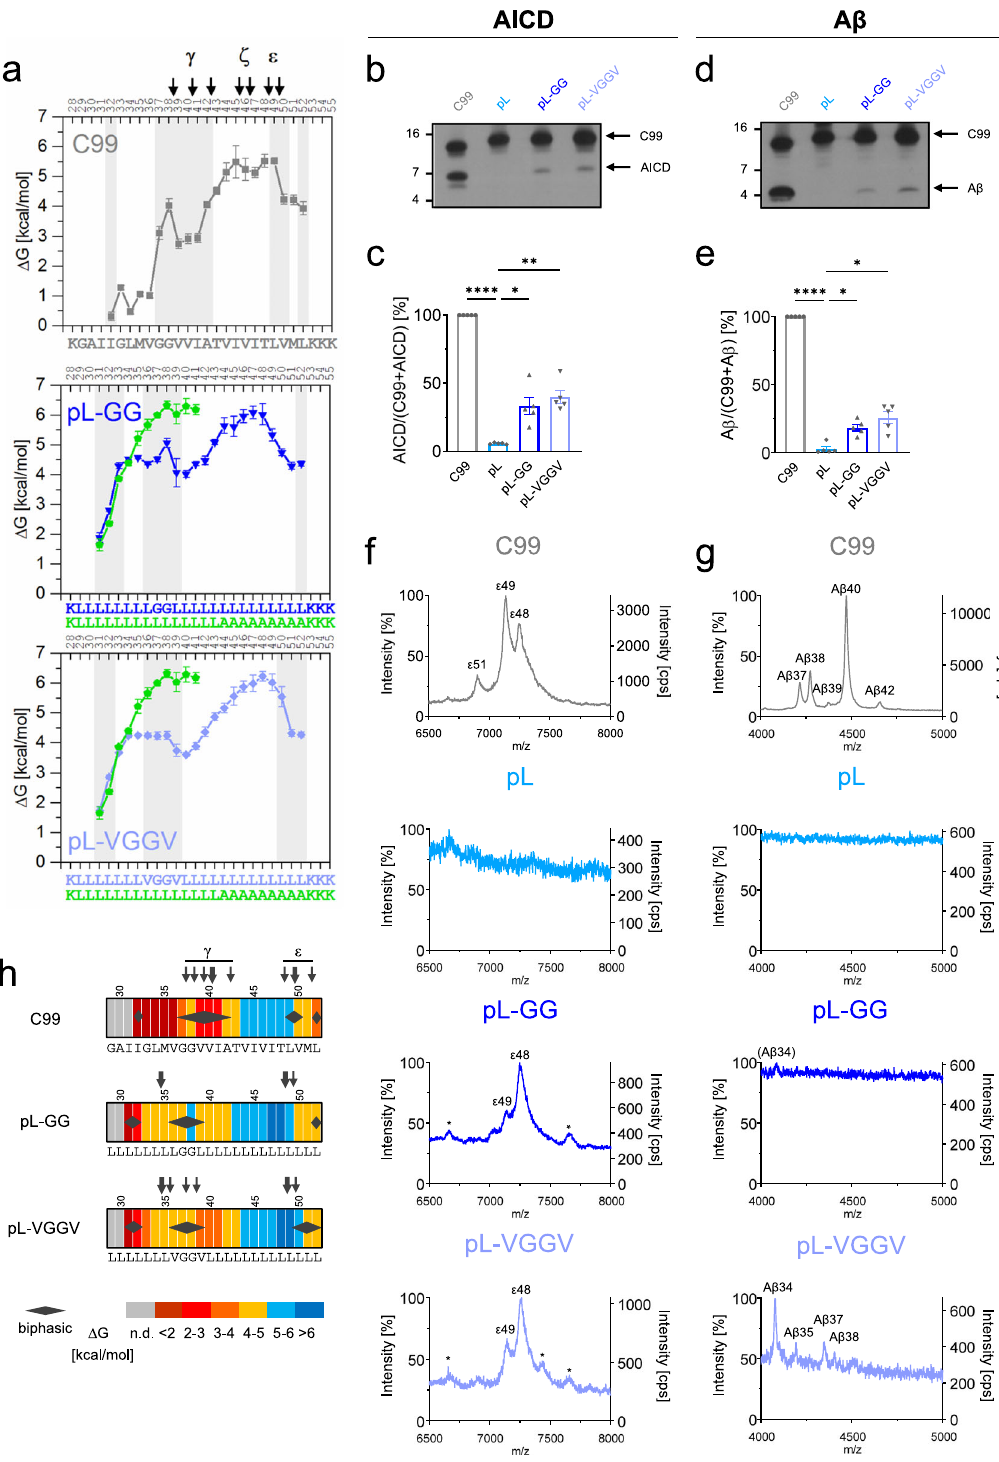
fi ndings again challenge the idea that helix fl exibility around the ε -cleavage sites scales with C99